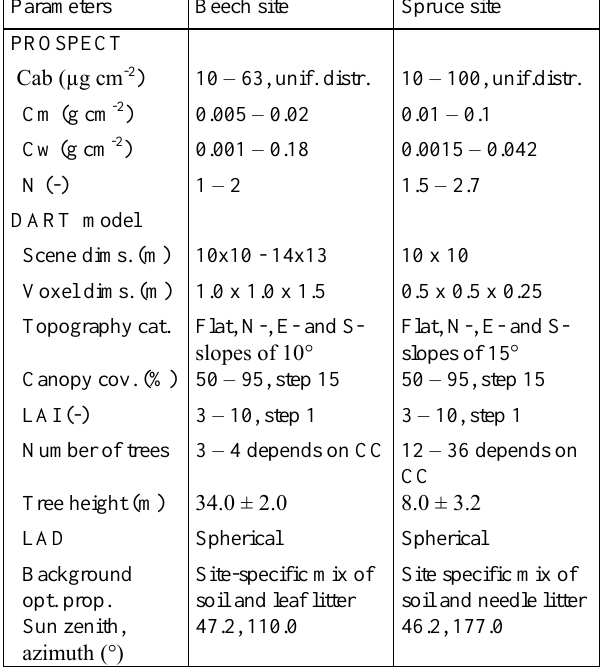
Table 2. Basic input parameters for the PROSPECT and DART models used to simulate beech and spruce spectral databases.